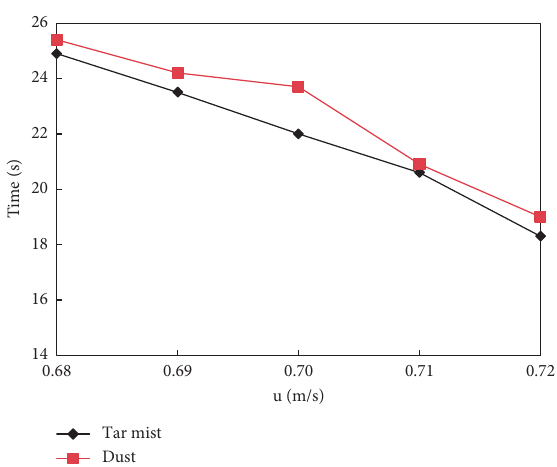
Figure 10: Particle removal time as a function of the gas velocity.